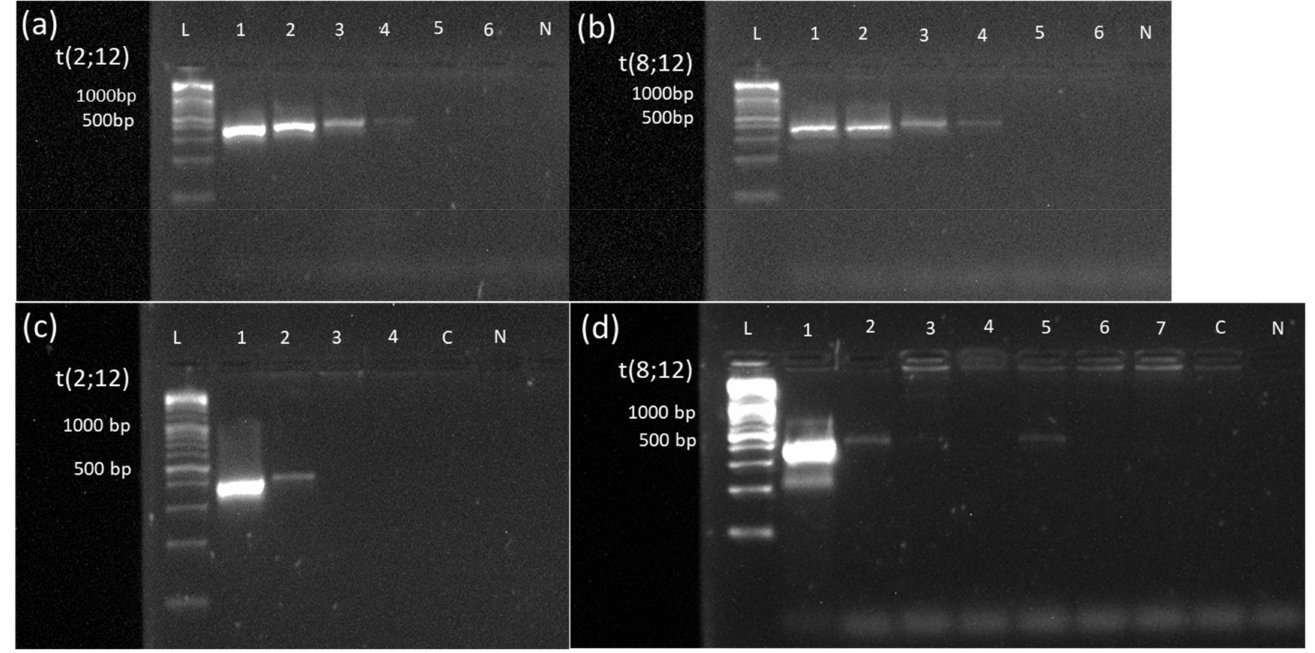
Figure 5. Sensitivity assessment of PCR-based MRD monitoring via a dilution series in cases #15 and #22 and Monitoring of MRD based on translocation t(2;12) and t(8;12) newly detected by OGM. A 10-logfold dilution series (100% to 0.001%) of the DNA sample from diagnosis into a healthy DNA sample was performed in cases #15 ( a ) and #22 ( b ). Specimen from the dilution series were